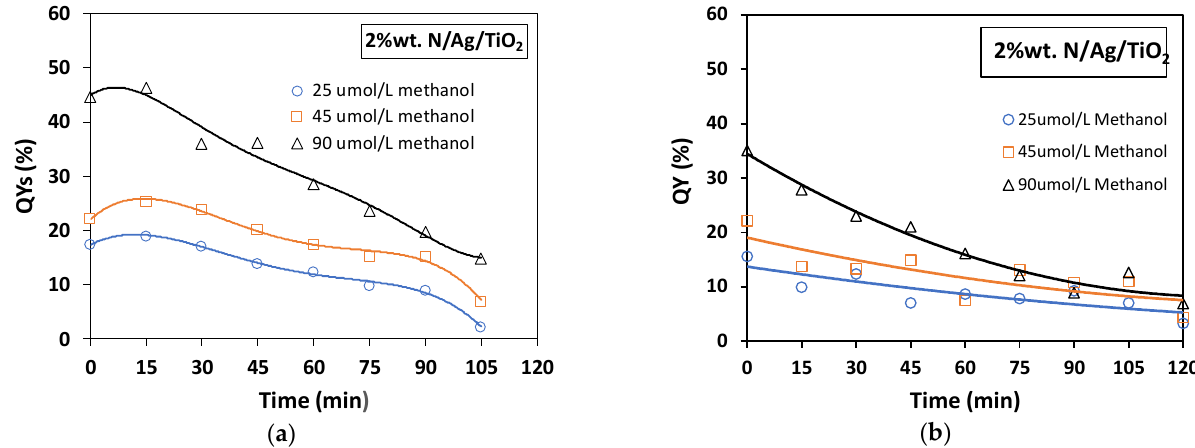
Figure 12. Quantum yields (QYs%) for photocatalytic methanol degradation using a 2 wt.% N/Ag/TiO 2 coated in a mesh. Runs were carried out using different irradiation sources: ( a ) near-UV light and ( b ) visible light, and at three different initial methanol concentrations of 25, 45 and 90 µmol/L. Note: Reported data are for at least three repeats with 10 ± 2% SD.